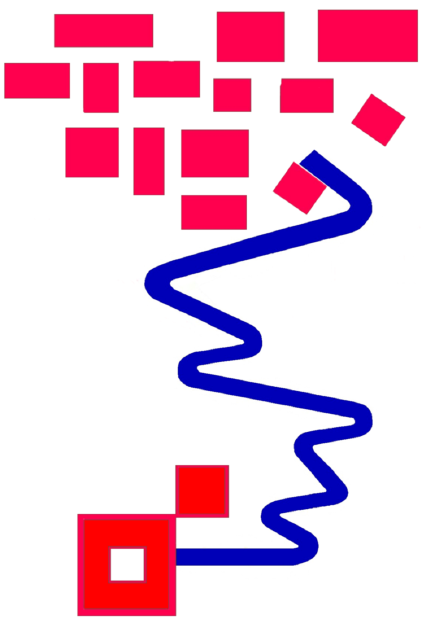
Figure 7. Sketch of the territory of Sclafani (detail) drawn by Giuseppe Massa (attrib. 1846–1850; not in scale and without ori- entation). The detail shows the small town, the ancient Sclafani spa and the connecting mule track. Drawing modified after Caruso and Nobili (2001).